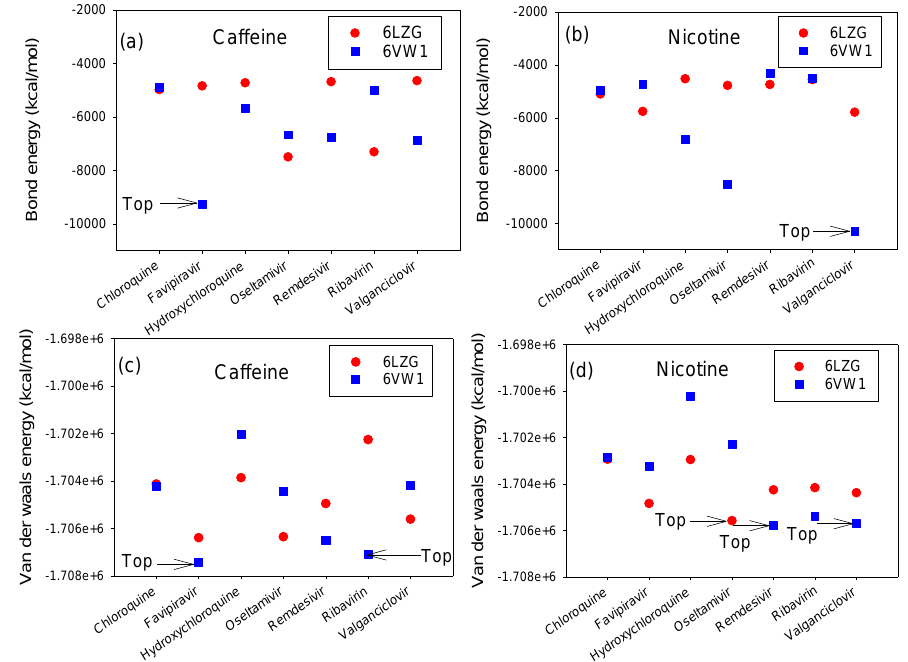
Figure 7. The bond and van der Waals energies for drug and caffeine/nicotine structures with 6VW1 (RBD-ACE2) and 6LZG (CTD-ACE2). (a), (b) The bond energies caffeine and nicotine, (c) and (d) the van der Waals energies caffeine and nicotine, respectively.